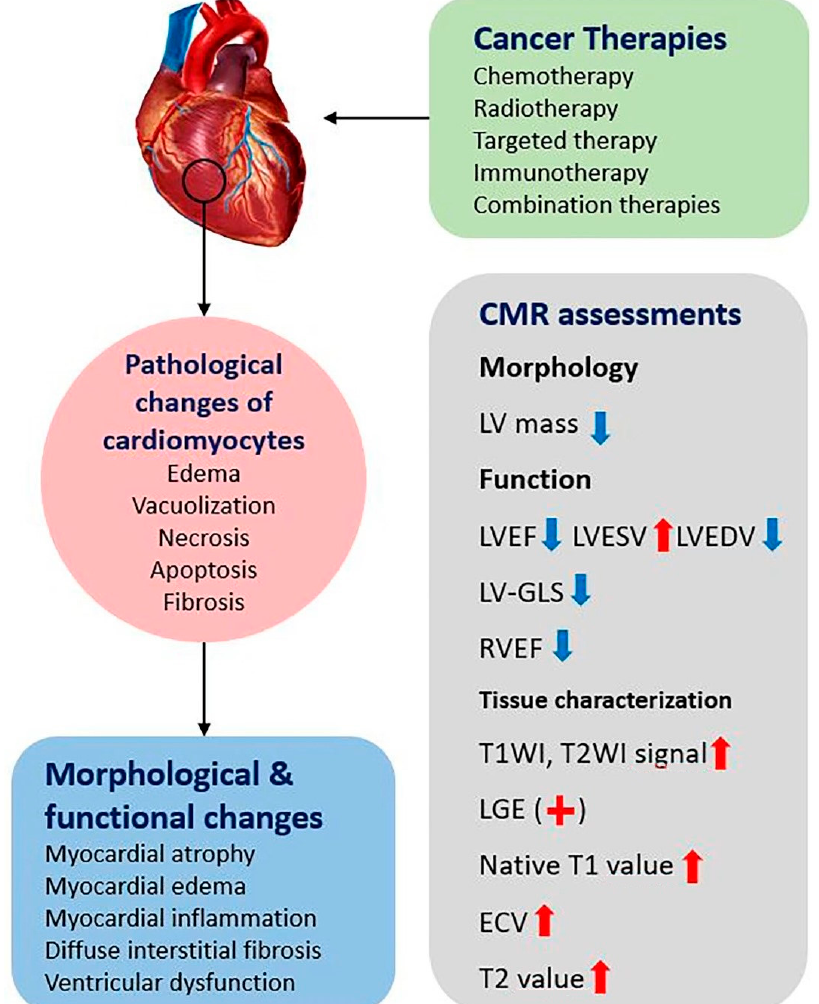
Figure 1. Overview of the pathological changes of cardiomyocytes in cardiotoxicity induced by cancer therapies, the resulting morphological and functional changes of the heart, and CMR assessments that have been performed in previous studies. Different CMR parameters may increase (red arrows) or decrease (blue arrows) or be positive (red plus) in cardiotoxicity. LV = left ventricular; LVEF = left ventricular ejection fraction; LVESV = LV end-systolic volume; LVEDV = LV end-diastolic volume; GLS = global longitudinal strain; RVEF = right ventricular ejection fraction; T1WI = T1-weighted imaging; T2WI = T2-weighted imaging; LGE = late gadolinium enhancement; ECV = extracellular volume fraction.